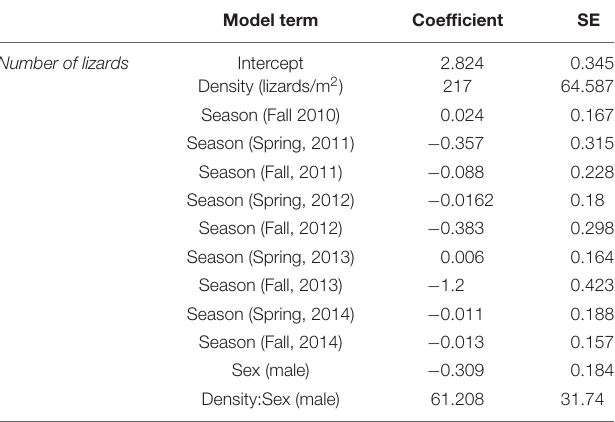
TABLE 1 | Best-fit models describing variation in number of lizards at the WSP population. Model term Coefficient SE Number of lizards